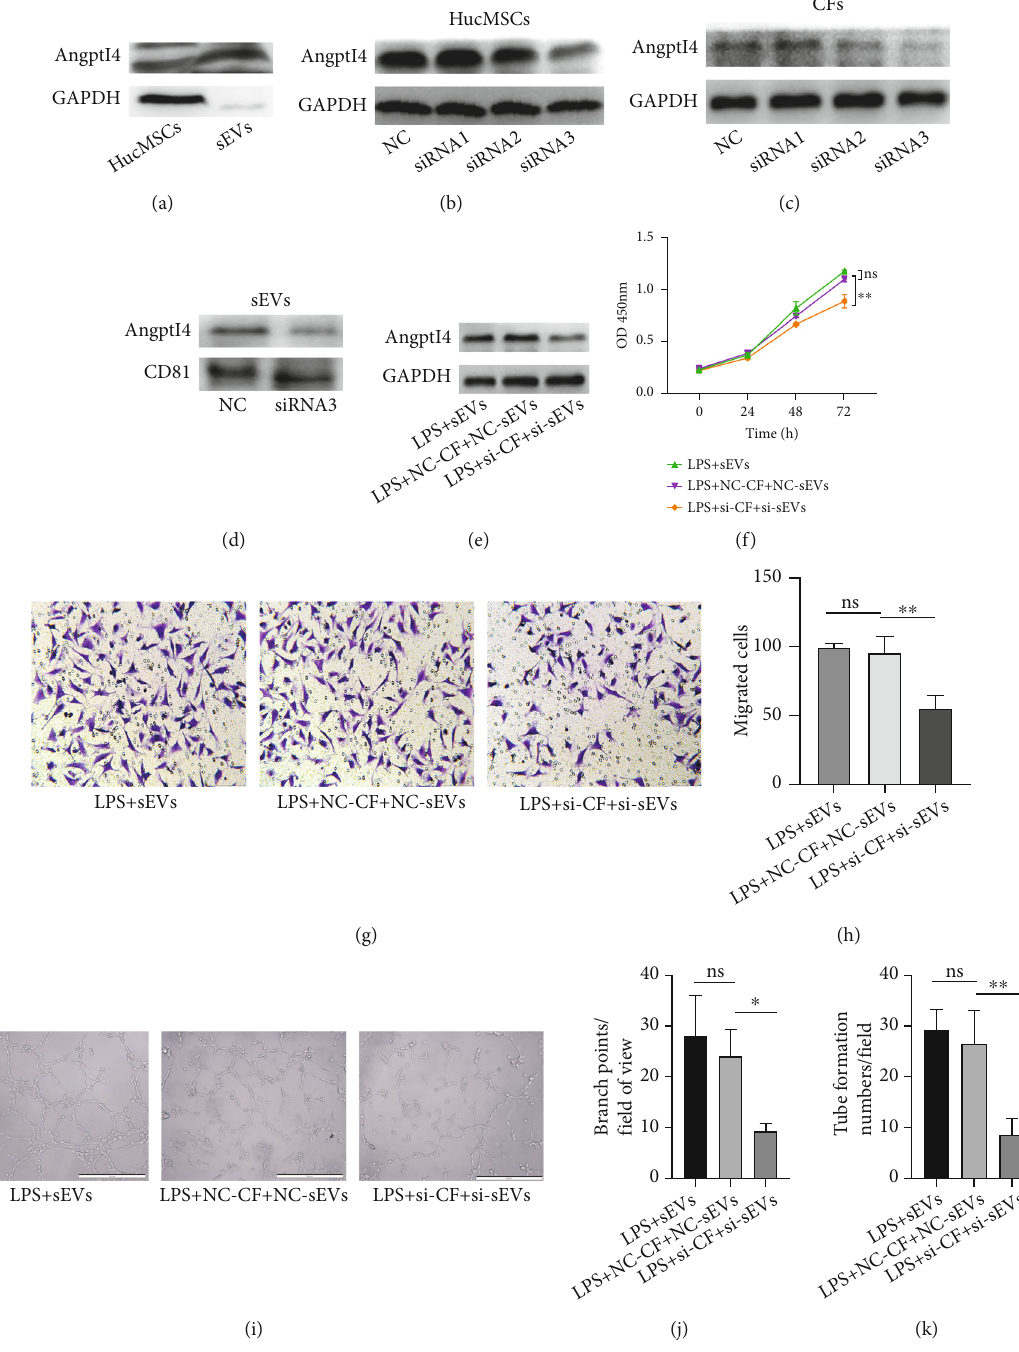
Figure 4: Inhibition of Angptl4 in primary CFs and sEVs resulted in decreased angiogenesis. (a) Angptl4 protein expression in hucMSCs and sEVs was detected by western blotting. (b, c) hucMSCs (b) and CFs (c) were transfected with Angptl4 siRNA, respectively, and expression of Angptl4 was measured by western blotting. (d) Angptl4 and CD81 expression in sEVs was observed by western blotting after transfection with siRNA. (e) Angptl4 expression in CFs was detected by western blotting after Angptl4 in CFs and in sEVs was knocked down with siRNA. (f) HUVECs were treated with the supernatants derived from pretreated CFs. The proliferation of HUVECs was measured by the CCK-8 assay. (g, h) The migration of HUVECs was detected by the Transwell migration assay (g). Scale bar: 100 μ m. Quantitative analysis of the migrated cells (h). (i – k) Tube formation ability of HUVECs was measured by tube formation assay (i). Quantitative analysis of the total branching points (j) and tube formation numbers (k). Scale bar: 500 μ m. ∗ P < 0 : 05 and ∗∗ P < 0 : 01 . ns: no signi fi cant di ff erence between two